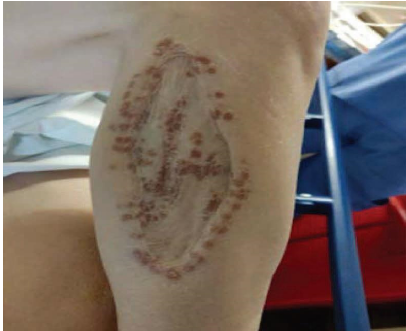
Figure 2: Well-circumscribed, reddish-brown, slightly scaly macules surrounding a large atrophic scar fgure from a prior skin graft on the right leg.